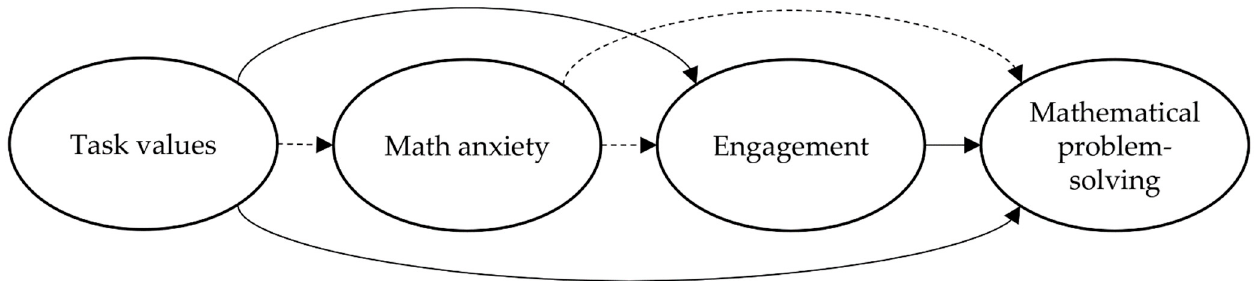
Figure 1. Hypothesis model of the current study. Solid lines represent positive relations; dashed lines represent negative relations.